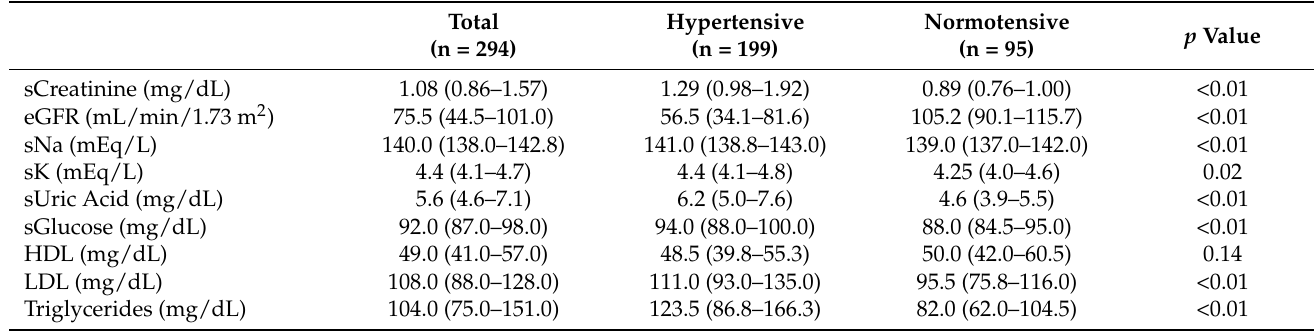
Table 2. Laboratory and echocardiographic parameters in ADPKD